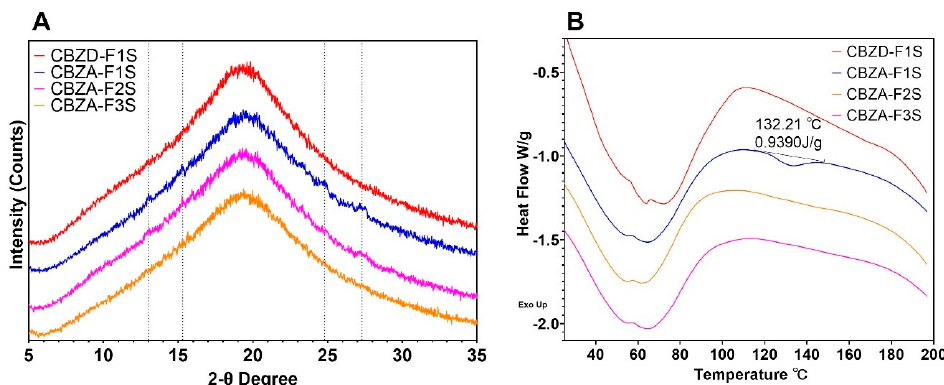
Figure 7. A . Degree of crystallinity of formulations using screw design 2 (Grey dot lines indicated the crystalline peaks observed in CBZA-F1S and CBZA-F2S); B . DSC thermograms of formulations using screw design 2.